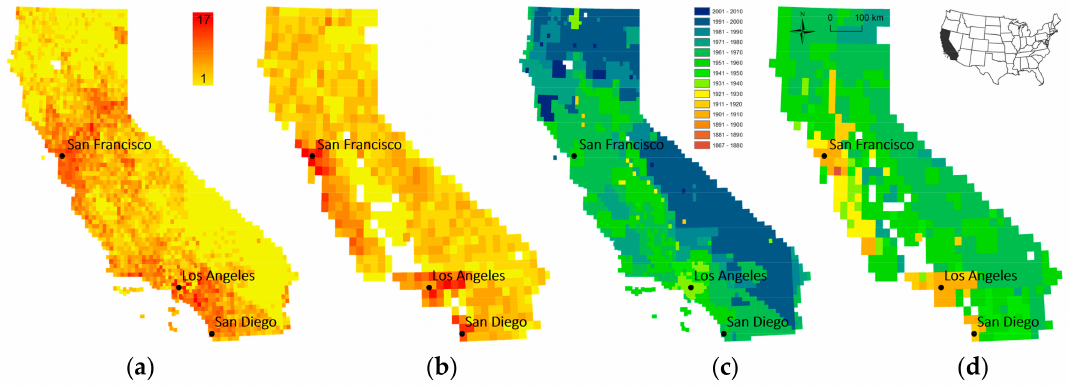
Figure 7. ( a ) Map edition counts per 1:24,000 map quadrangle, ( b ) map edition counts per 1:62,500 map quadrangle, ( c ) earliest map production year per 1:24,000 map quadrangle, and ( d ) earliest map production year per 1:62,500 map quadrangle in the state of California (USA) based on metadata